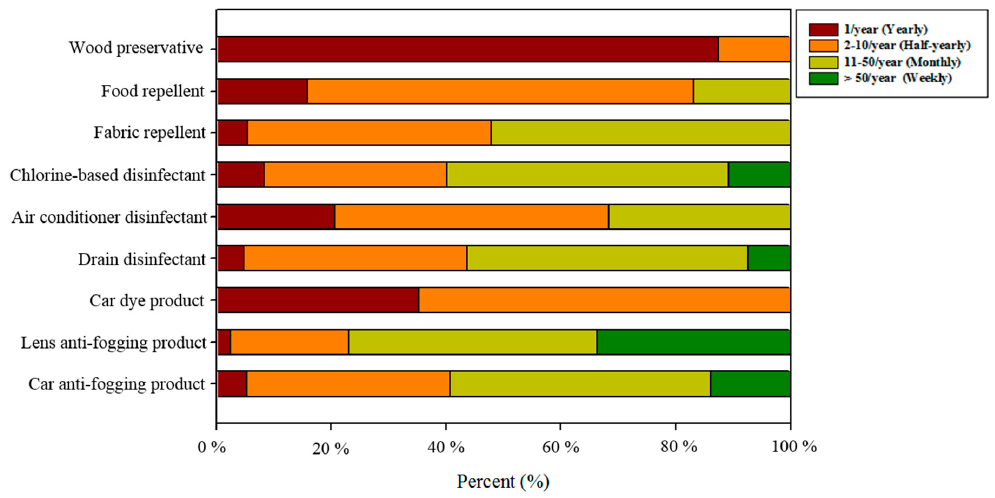
Figure 2. Frequency of use by product.